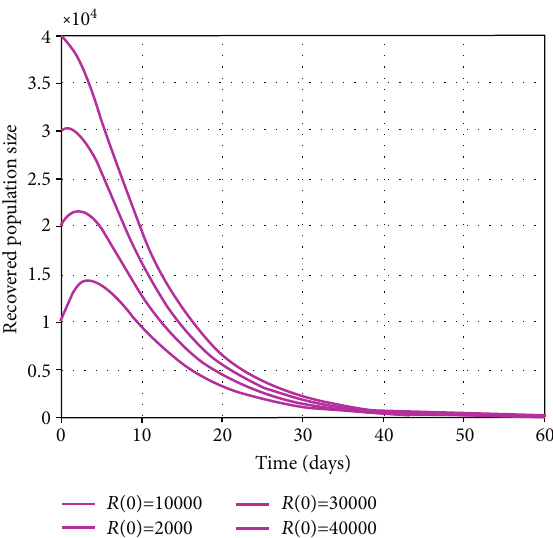
Figure 7: The time series plot of the recovered population. Figure